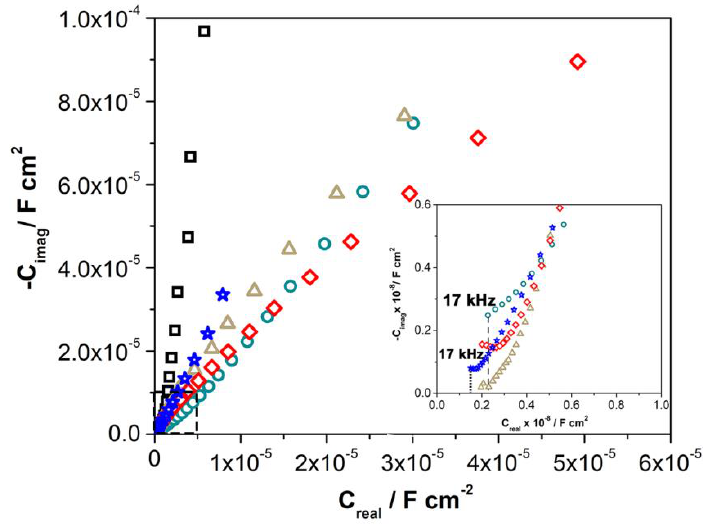
Figure 15. Cole – Cole plots of copper after exposure in 0.1 M Na 2 SO 4 solution at E = OCP. No expo- Figure 15. Cole–Cole plots of copper after exposure in 0.1 M Na 2 SO 4 solution at E = OCP. No sure (□), 3 months ( ○ ), 12 months ( △ ), 24 months ( ◇ ), and 36 months ( ☆ ). exposure ( □ ), 3 months ( # ), 12 months ( △ ), 24 months ( 3 ), and 36 months ( ☆ ).